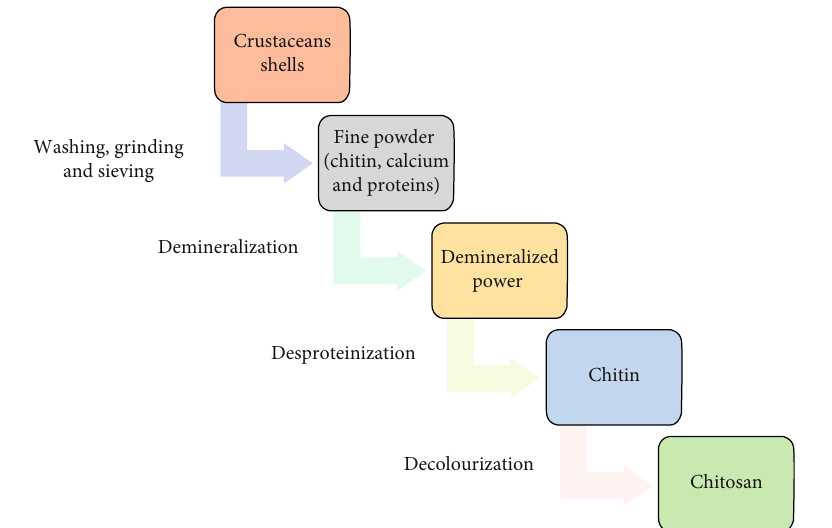
Figure 14: Extraction procedures for chitin and chitosan.